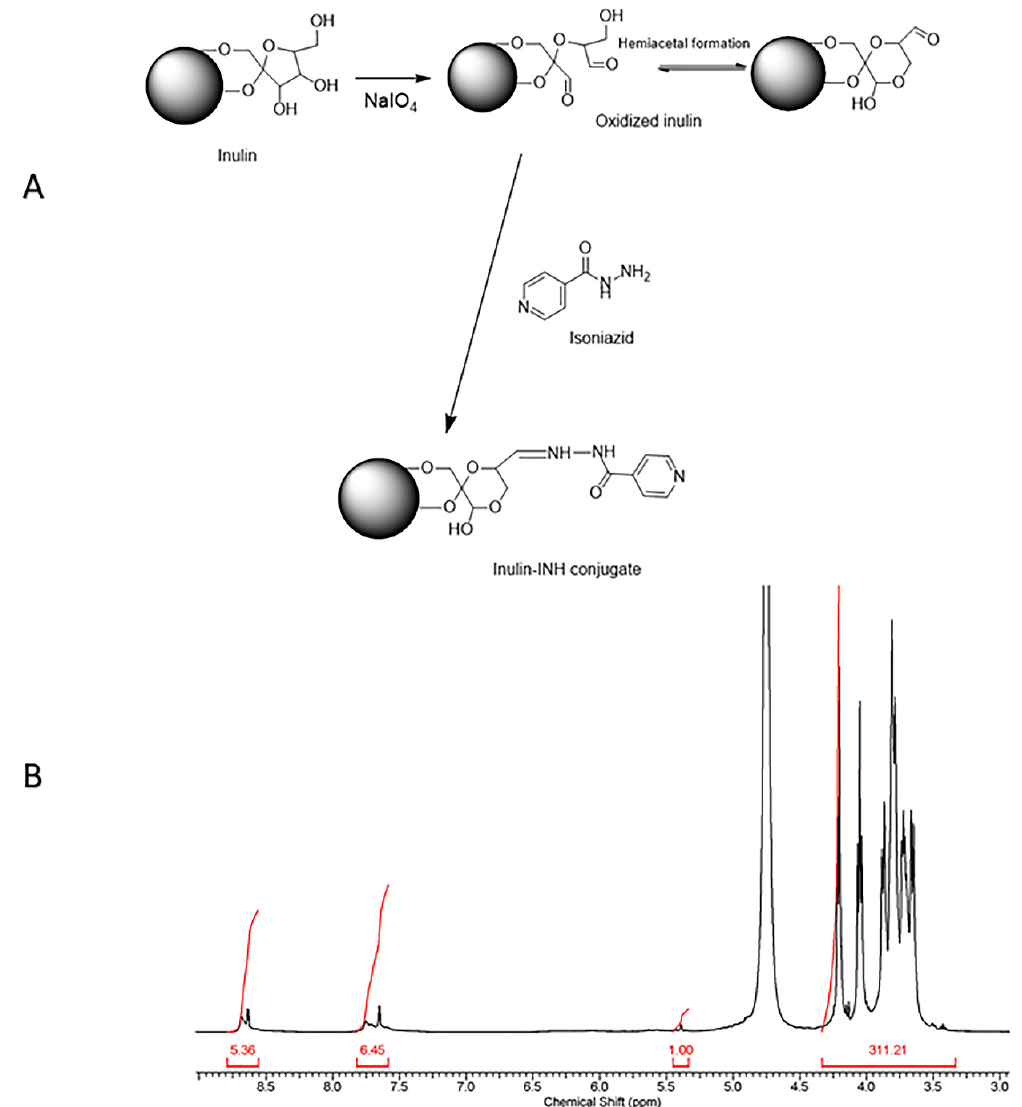
Figure 1. ( A ) showing the oxidation of inulin and coupling of isoniazid to inulin particles ( B ) 1 H nuclear magnetic resonance (NMR) spectrum of inulin conjugate confirming isoniazid (INH)